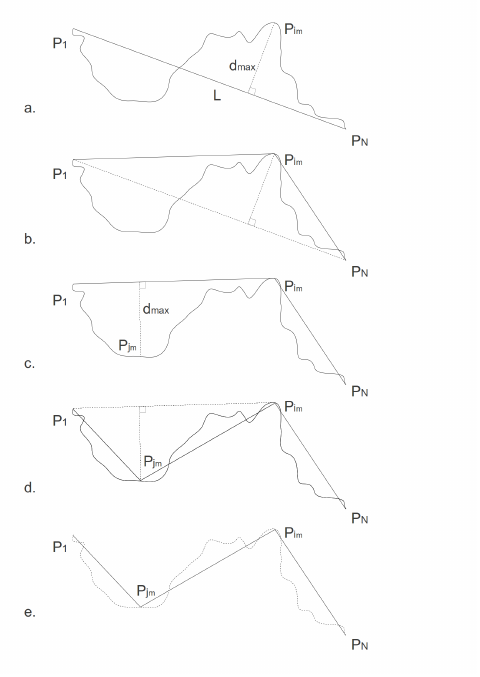
Figure 2: Illustration of the polygonal